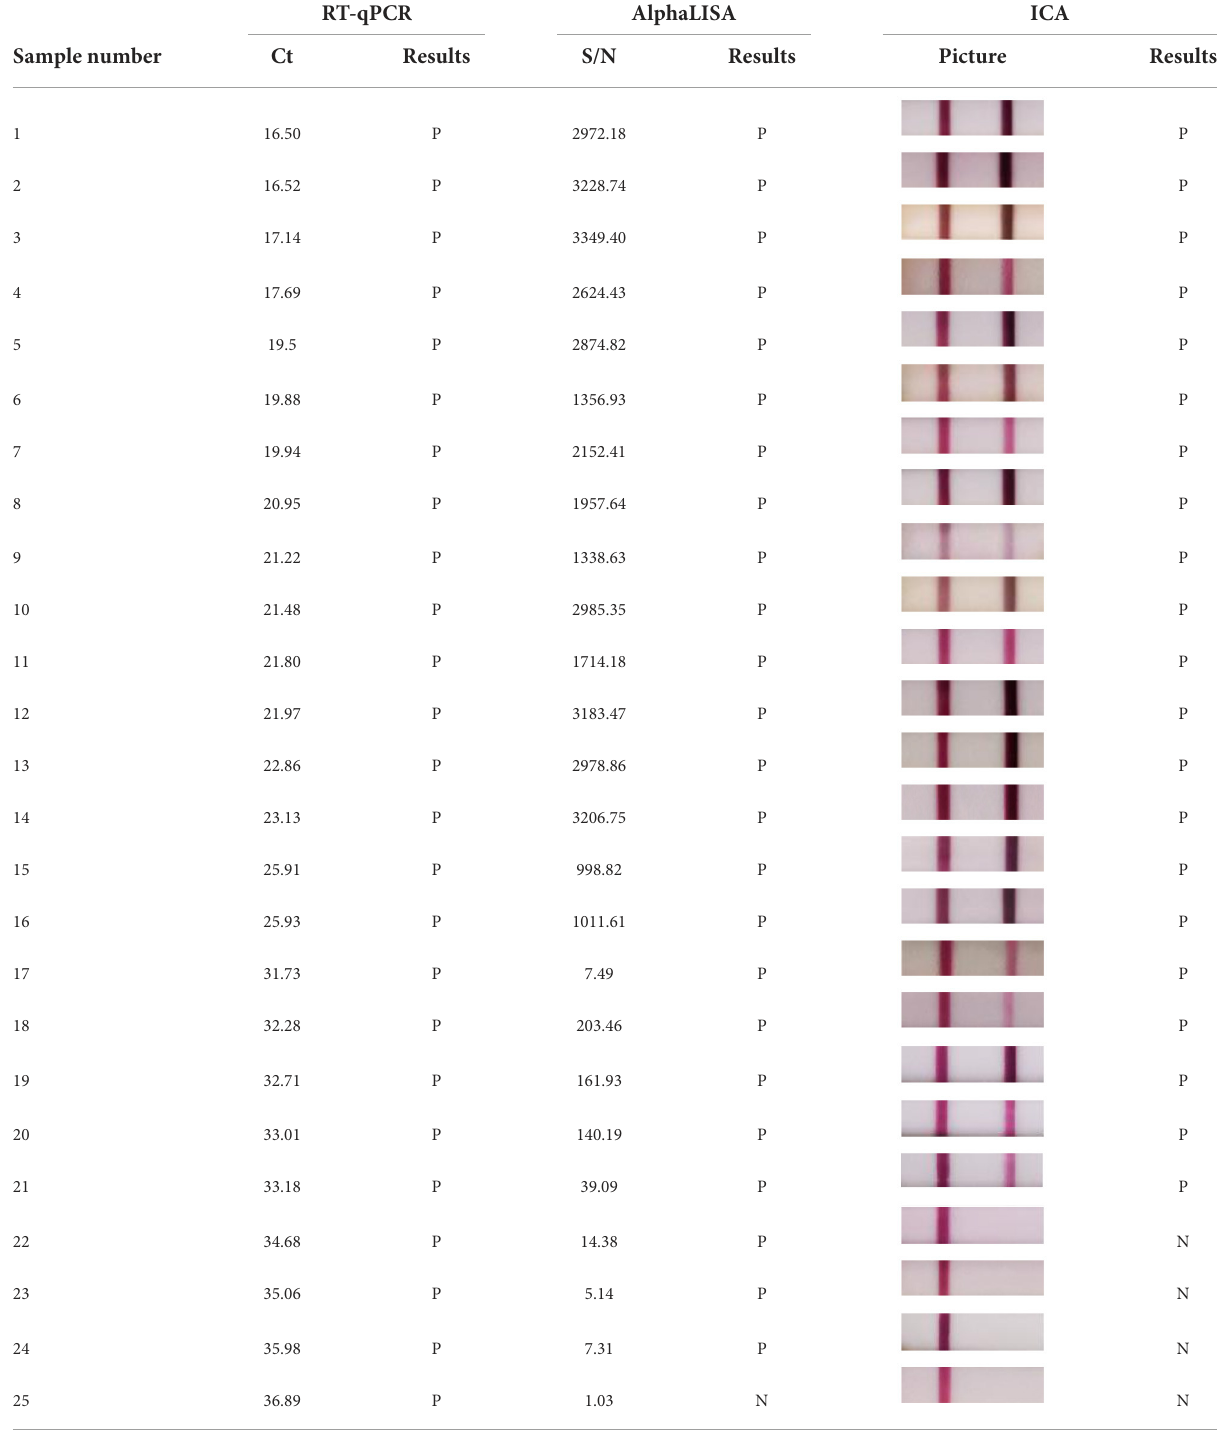
TABLE 3 The test results of rotavirus-positive stool samples. RT-qPCR AlphaLISA ICA Sample number Ct Results S/N Results Picture